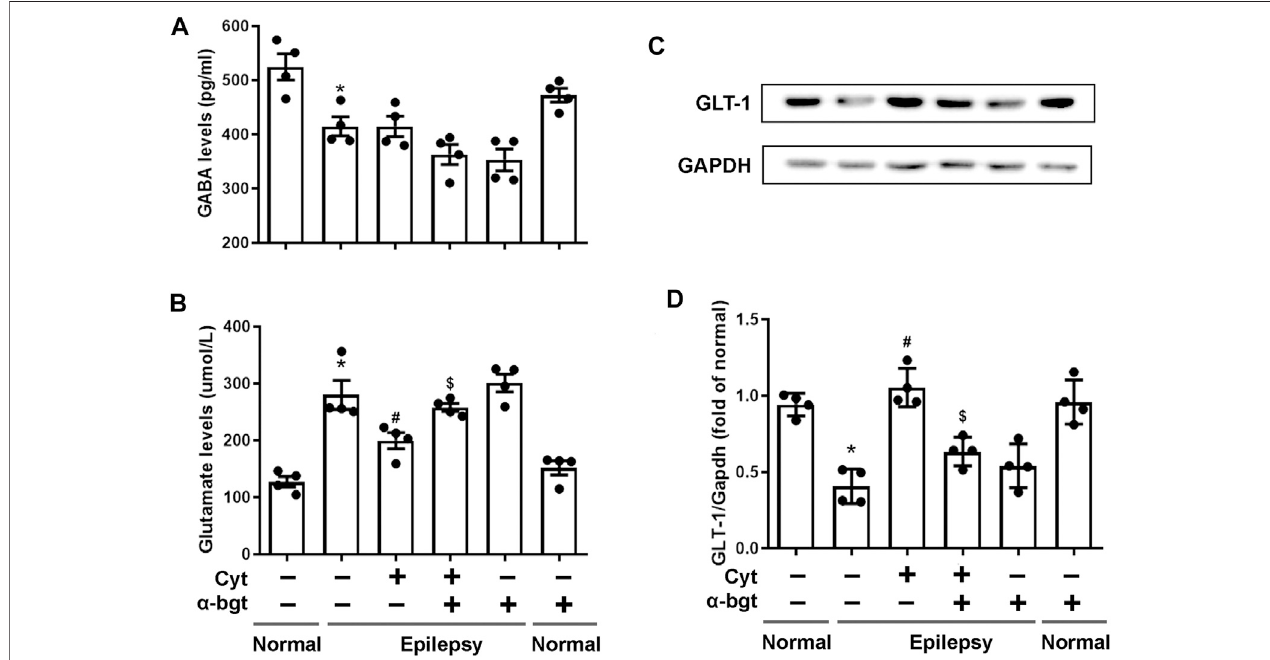
FIGURE 3 | In fl uences of cytisine treatment on neurotransmitter levels in the hippocampi of epileptic rats. A – B: GABA and glutamate levels in the hippocampus weremeasured bycolorimetry.Statistical results areasfollows: GABA: F (5,18) (cid:1) 11.924, p < 0.05, n (cid:1) 4; normal vs. epilepsy, * p < 0.05; epilepsy vs. epilepsy + Cyt, p > 0.05; epilepsy + Cyt vs. epilepsy + Cyt + α -bgt, p > 0.05; Glu: F (5,18) (cid:1) 21.889, p < 0.05, n (cid:1) 4; normal vs. epilepsy, * p < 0.05; epilepsy vs. epilepsy + Cyt, # p < 0.05; epilepsy+Cytvs.epilepsy+Cyt+ α -bgt, $ p < 0.05. C – D: GLT-1expressioninthehippocampuswasanalyzedbyWesternblotting.Statisticalresultsareasfollows: GLT-1:F (5,18) (cid:1) 19.741, p < 0.05, n (cid:1) 4; normal vs. epilepsy, * p < 0.05; epilepsy vs. epilepsy + Cyt, # p < 0.05; epilepsy + Cyt vs. epilepsy + Cyt + α -bgt, $ p <